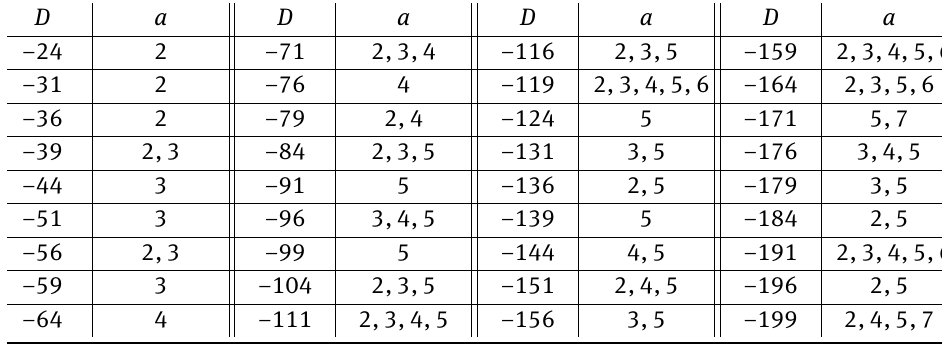
Table 1: The coefficients of x 2 of non-principal reduced form Q = [ a , b , c ] ∈ C ( D ) for D ≡ (cid:3) ( mod 100) relatively prime to 5 for D > −200